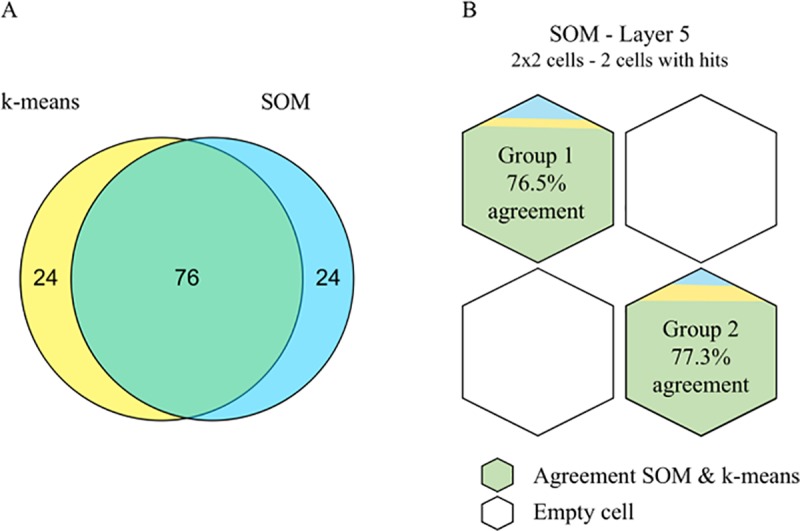
Comparison between clustering outcomes of the k-means and SOM.(A) Venn diagram of the overlap between the k-means and the SOM. (B) Overlap between the two clustering methods shown as the percentage of patients from each group identified by the SOM that was identically classified by the k-means. For visualization, the two groups are drawn on the map of layer 5 of the SOM.